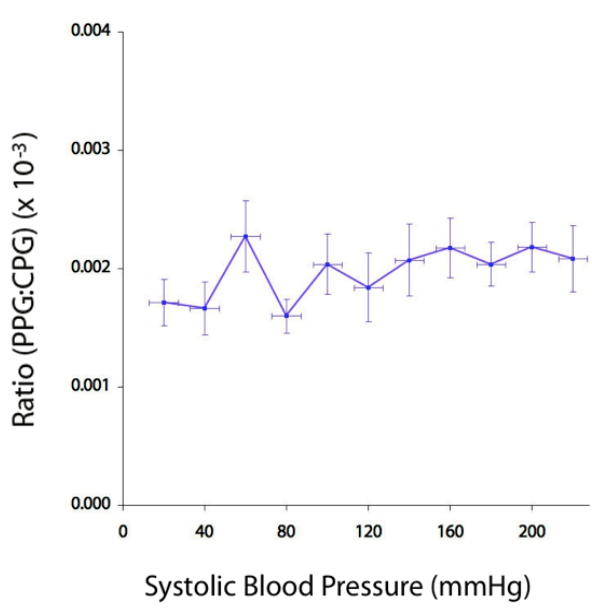
Figure 9. Graph of ratio of mean (±SD) normalized amplitudes (PPG:CPG ratio) plotted against pulse